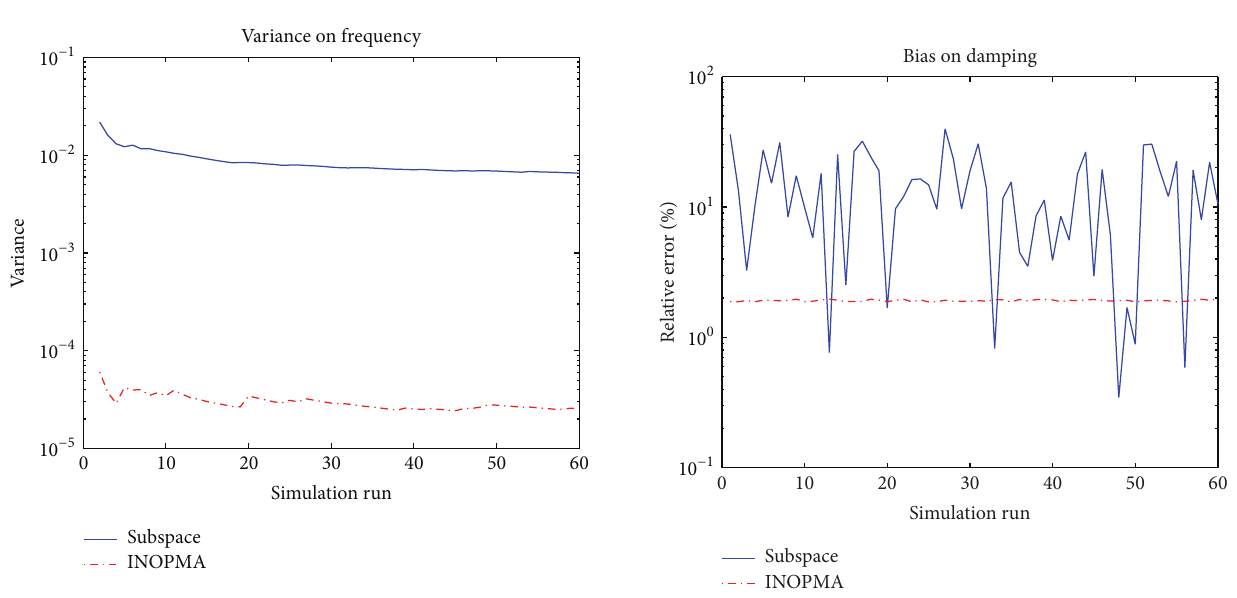
Figure 1: Variance on damping: SDOF case.